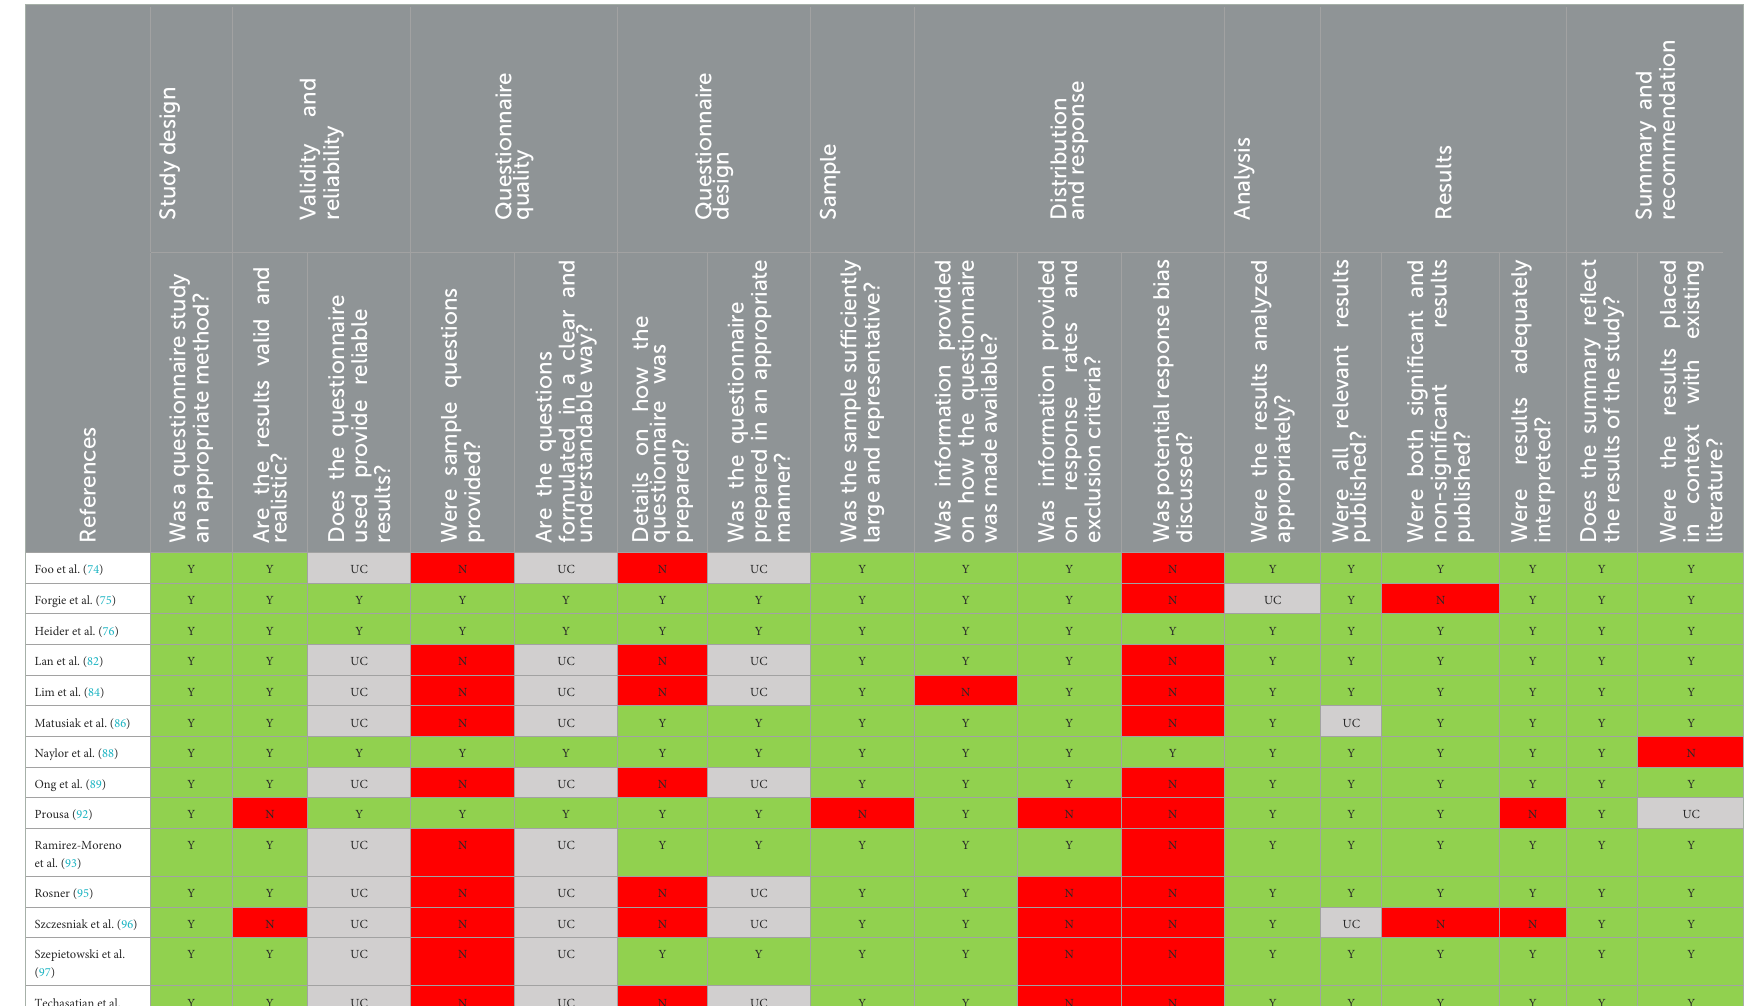
TABLE 2D Quality appraisal of the questionnaire studies (CASP